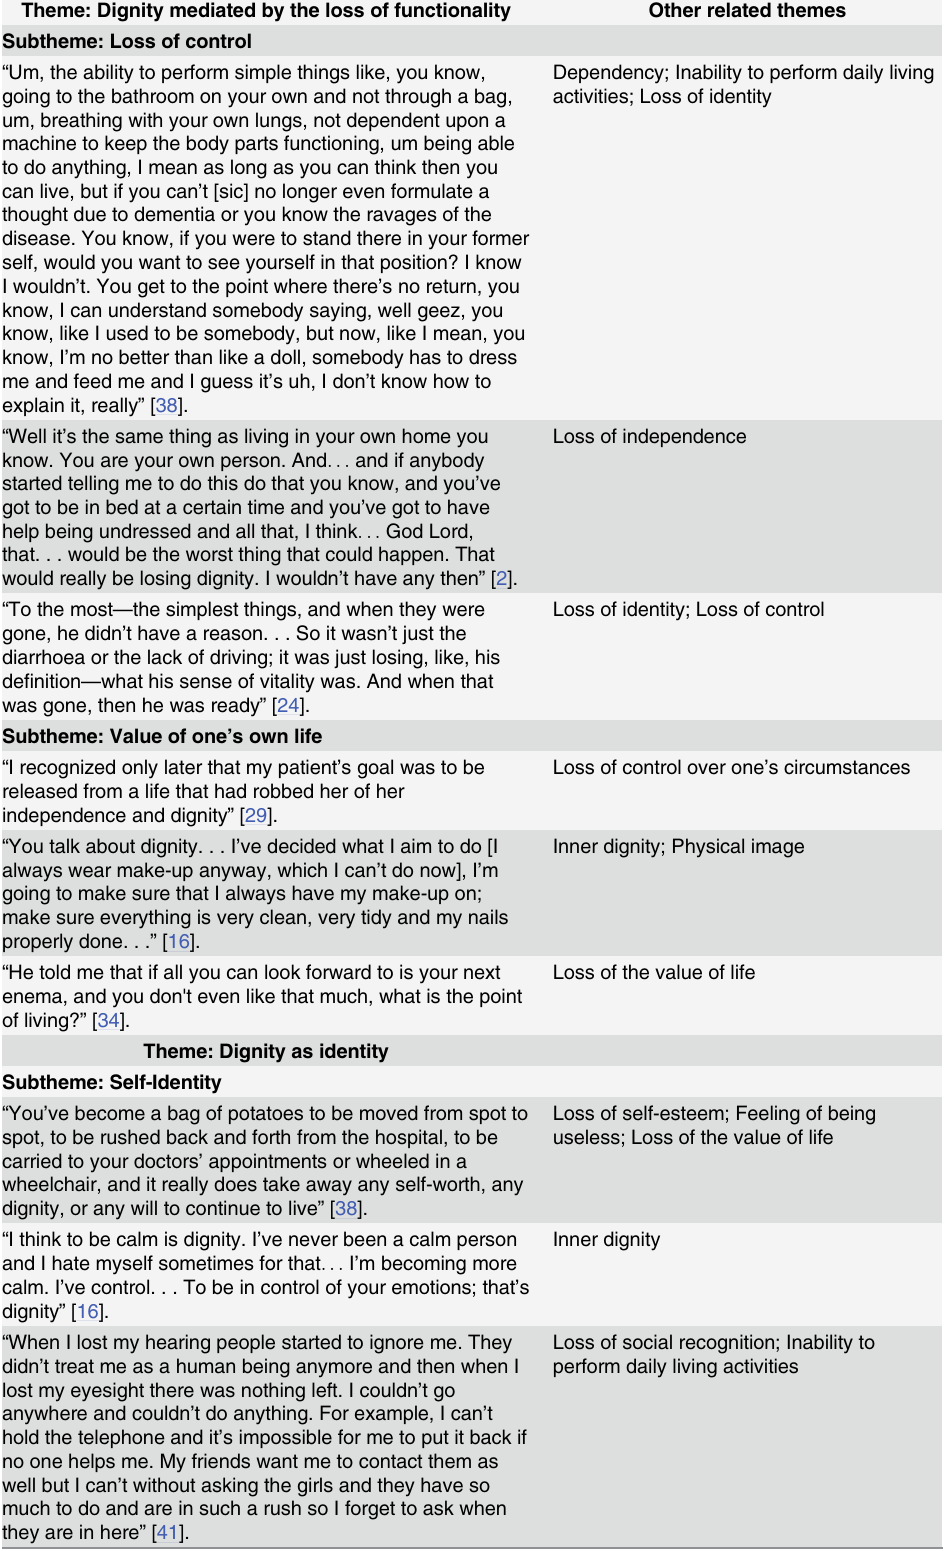
Table 4. Some quotations from participants in the primary studies that illustrate each